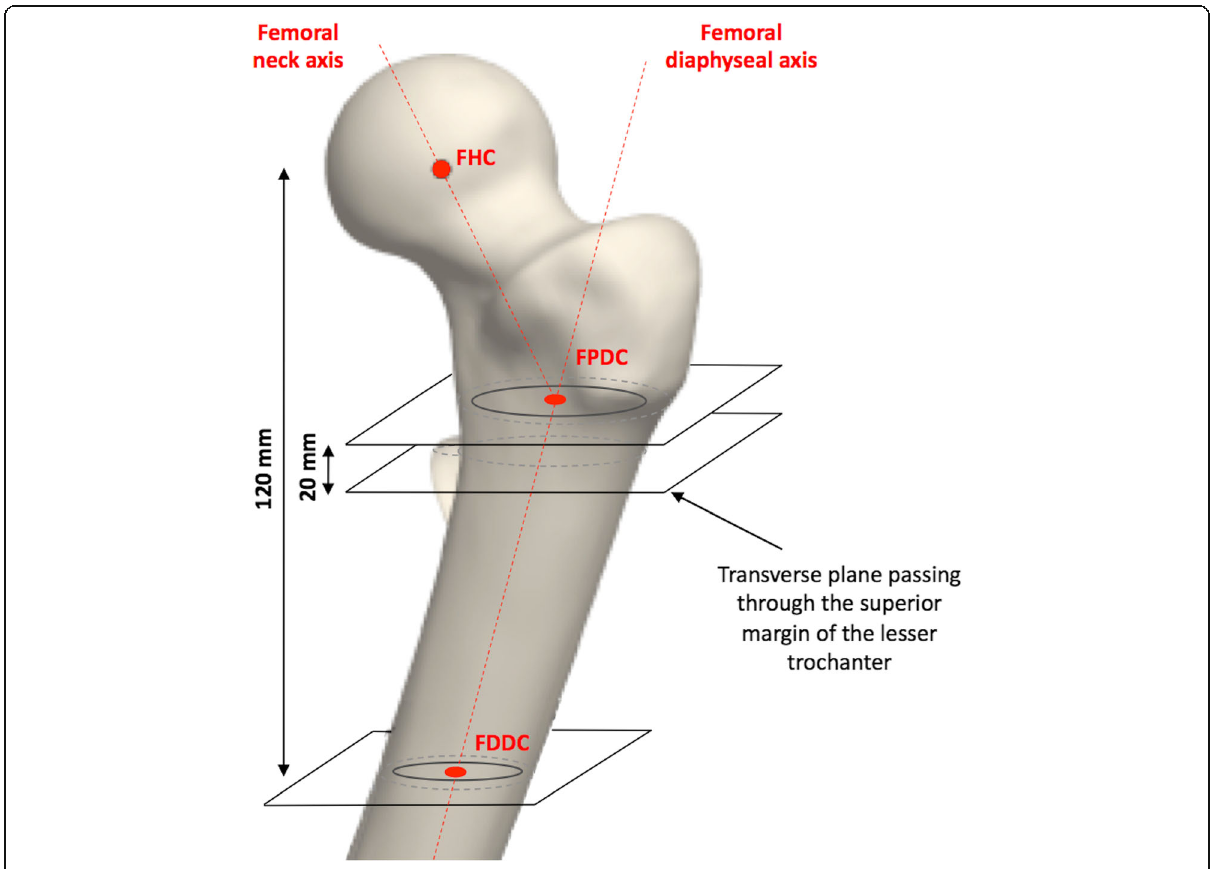
Fig. 2 Anatomic landmarks, axes and dimensions determined for each hip. The Femoral Head Center (FHC) is determined by fitting a ‘ sphere of best fit ’ to the femoral head. The Femoral Distal Diaphysis Center (FDDC) is determined by fitting an ellipse to the intramedullary cortex 120 mm below the FHC. The Femoral Proximal Diasphysis Center (FPDC) is determined by fitting an ellipse to the intramedullary cortex 20 mm above the superior margin of the lesser